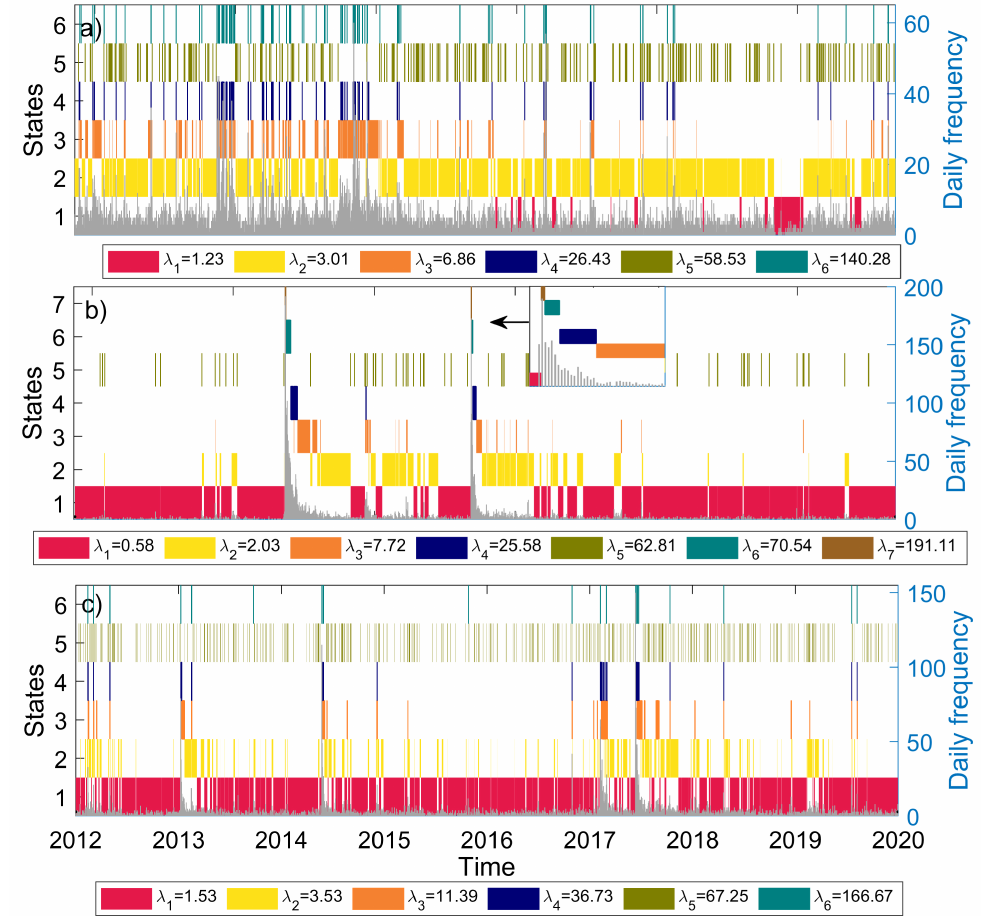
Figure 3. Most probable path of the hidden states of the model along with the daily frequency of events (gray vertical lines) with ( a ) M ≥ 1.5 for D1, ( b ) M ≥ 2.2 for D2 and ( c ) M ≥ 2.1 for D3 datasets, respectively. Each color is assigned to a different state i with seismicity rate λ i . Inset magnifies the transitions among the states, which are otherwise difficult to visualize due to the short sojourn times compared to the study period. The rate threshold, λ thr , is set equal to λ 2 = 3.01, λ 1 = 0.58, λ 1 = 1.53 for the D1, D2 and D3 datasets,